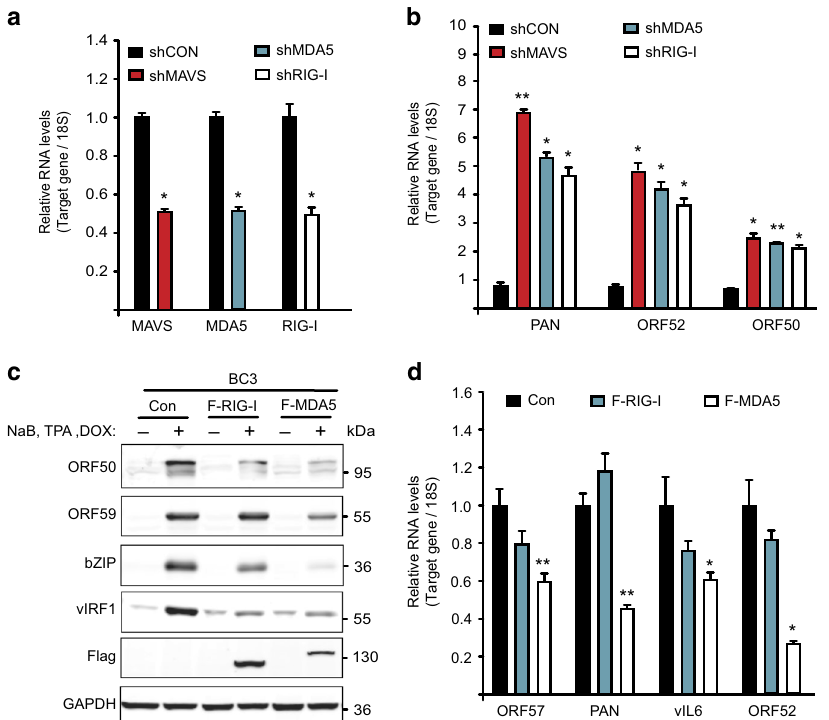
Fig. 3 RLRs-MAVS signaling pathway restricts KSHV lytic reactivation in BC-3 cells. a RNA was extracted from BC-3 cells expressing the indicated shRNAs and the target mRNA level was quanti fi ed by RT-qPCR. b Expression of KSHV viral genes in cells described in ( a ) was quanti fi ed by RT- qPCR. c BC-3 F- RIG-I, F-MDA5, and Control (Con) cells were reactivated for 48 h. Cell lysates from latent and lytic cells were analyzed by immunoblotting for the indicated proteins. d RNA was extracted from BC-3 cells described in ( c ) and expression of the indicated viral genes was quanti fi ed by RT-qPCR. Error bars in all panels represent mean ± SD from three independent experiments. p-values were determined by the Student ’ s t test, * p < 0.05, ** p <